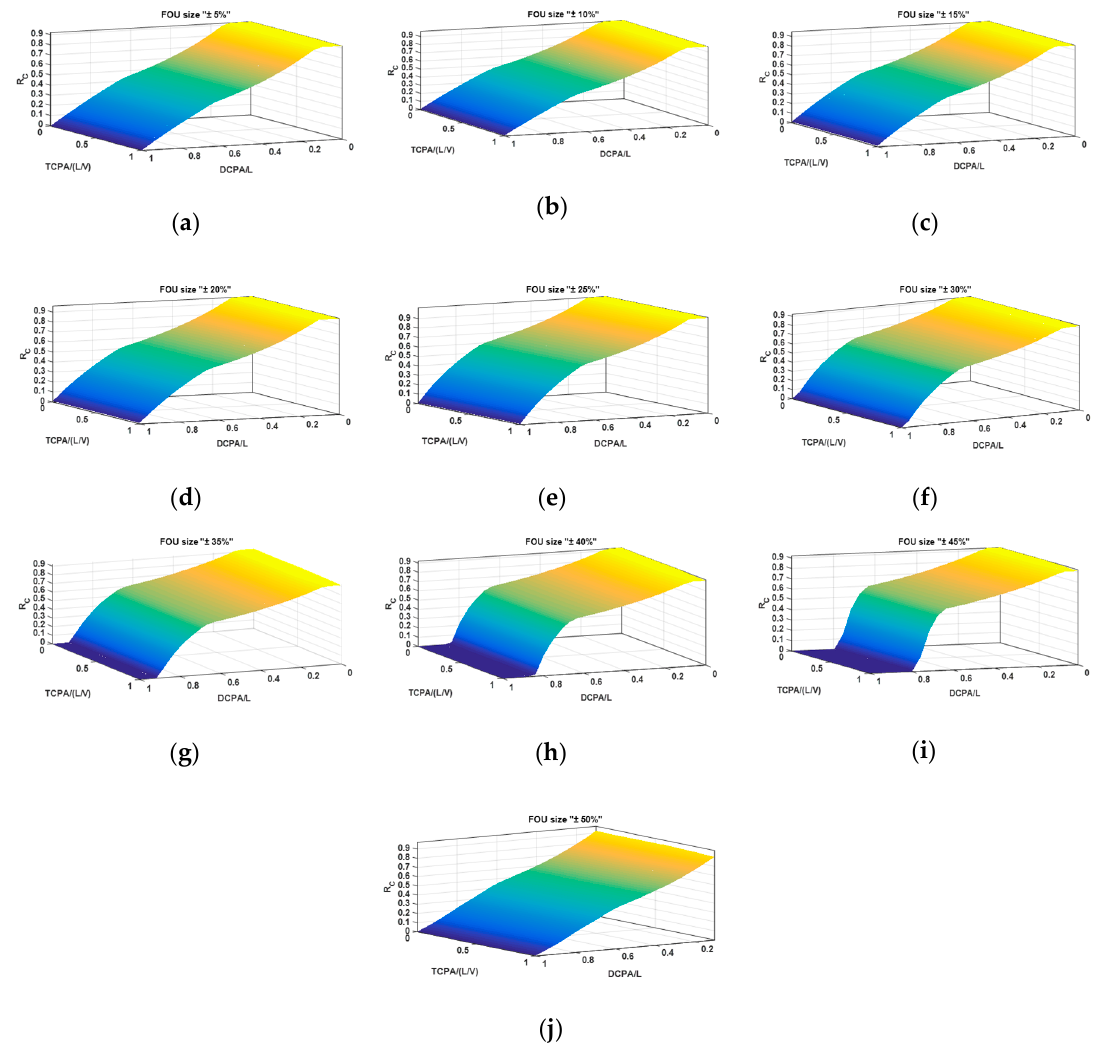
Figure 11. Surface of the IT2FIS: ( a ) Footprint of Uncertainty (FOU) size “ ± 5%”; ( b ) FOU size “ ± 10%”; ( c ) FOU size “ ± 15%”; ( d ) FOU size “ ± 20%”; ( e ) FOU size “ ± 25%”; ( f ) FOU size “ ± 30%”; ( g ) FOU size “ ± 35%”; ( h ) FOU size “ ± 40%”; ( i ) FOU size “ ± 45%”, and ( j ) FOU size “ ± 50%”.